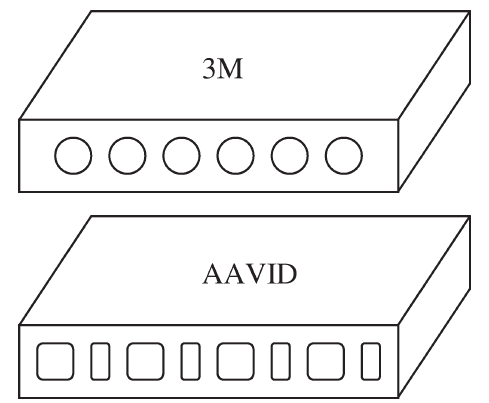
Fig. 1. MCHEX with holes perpendicular to the long axis of the